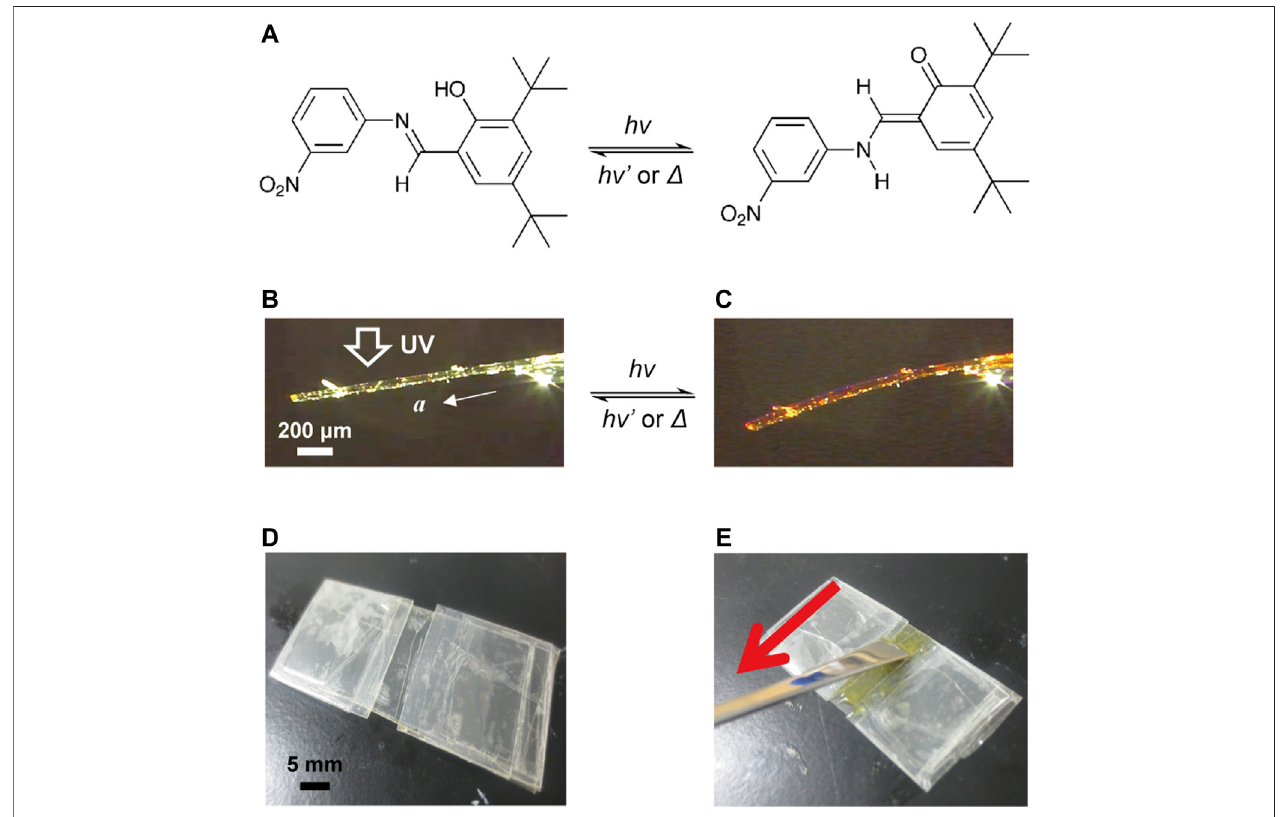
FIGURE 1 | (A) Enol – keto photoisomerization of salicylideneaniline 1. (B,C) Bending of a plate-like enol- 1 crystal (1410 μ m long × 95 μ m wide × 47 μ m thick) (B) before and (C) after UV light irradiation from the top side. (D) A shallow groove mold made of polypropylene fi lms. (E) A “ rubbing ” technique in which the surface of polymer suspension in the mold is stroked with a spatula to align the crystals with the long direction along the rubbing